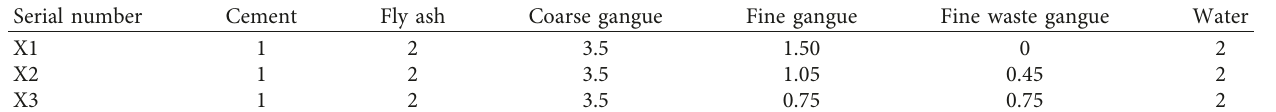
Table 3: Mixing ratio of the CGB and CWCGB.